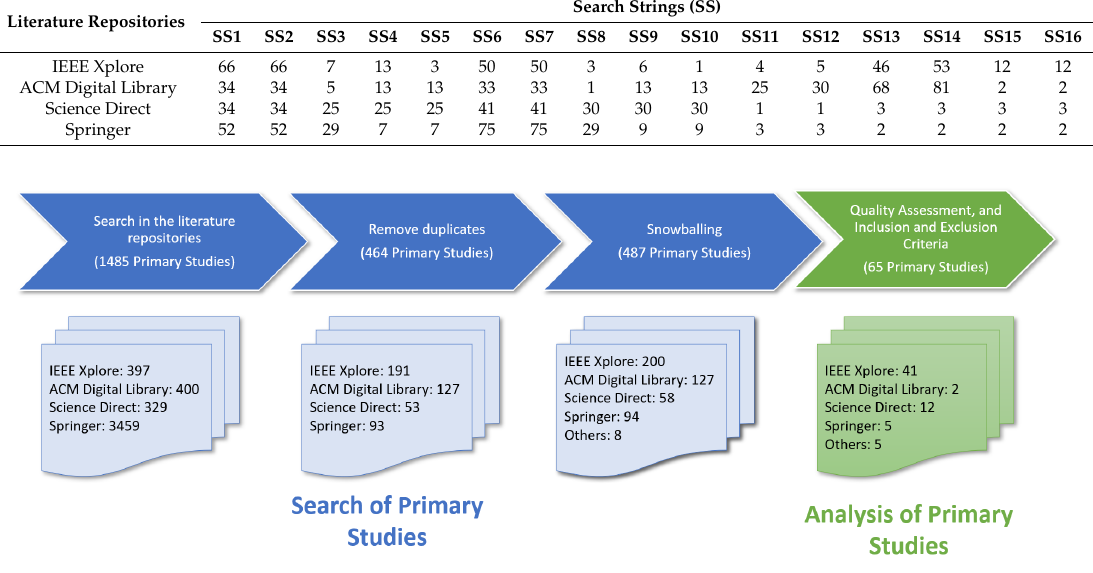
Figure 1. The resulting primary studies after each action carried out in the two stages: search of primary studies and analysis of primary studies.